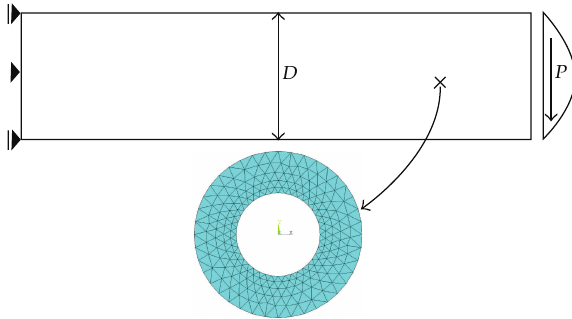
Figure 8: An elastic cantilever beam and the microscopic cell with a hole in it.